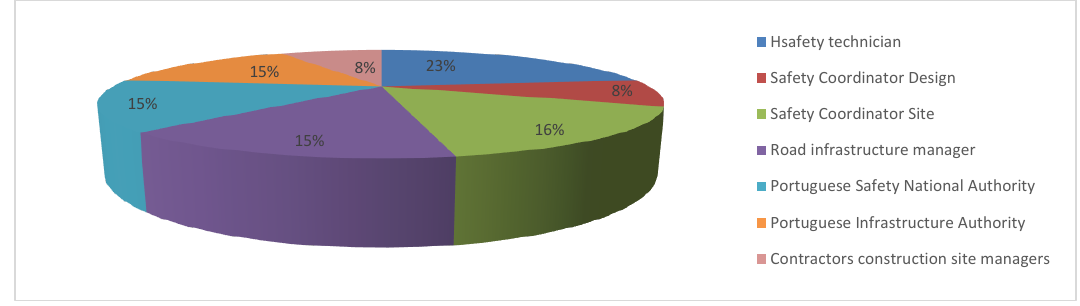
Figure 2. Experts’